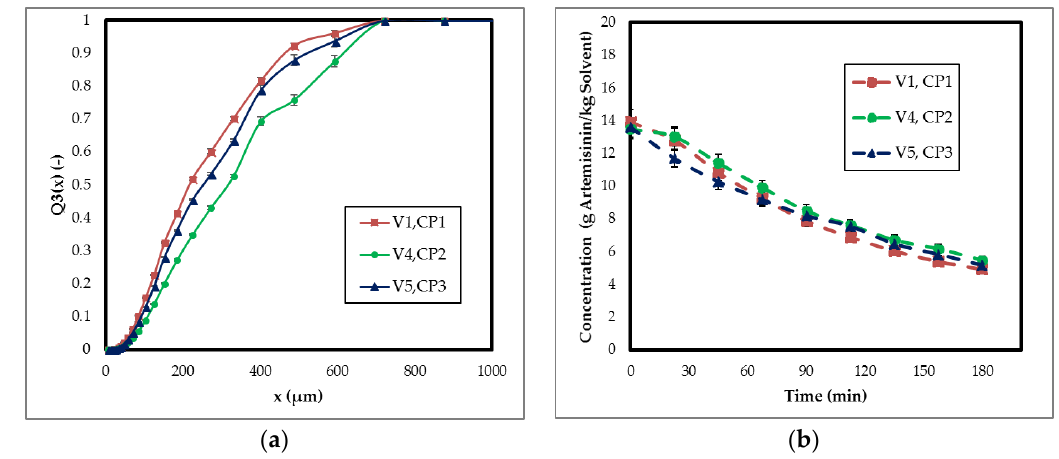
Figure 7. Process reproducibility: ( a ) particle size distribution, ( b ) concentration profile. (CP: Center point)